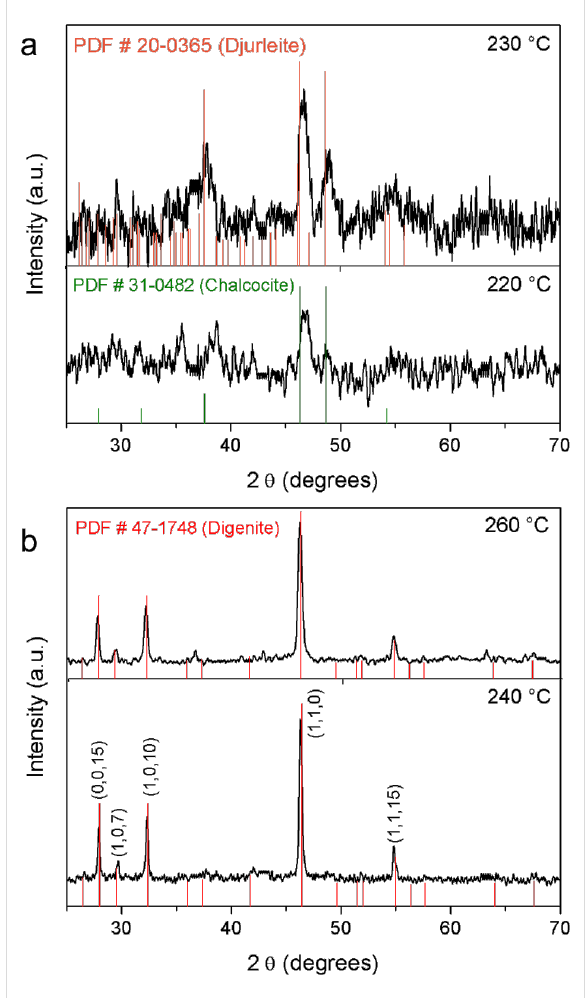
Figure 1: X-ray patterns of copper sulfide synthesized in organic solu- tion at a) 230 and 220 °C, the chalcocite phase is obtained and at b) 240 and 260 °C, the predominant phase is the